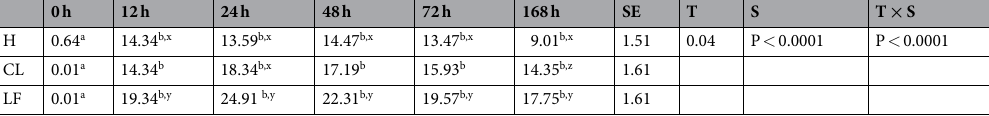
Table 1. Least square means (SEM) for serum IgG concentrations (mg/mL) from birth (d 0) to 168 h hours (h) for the calf progenies of H, CL and LF cows. T; Treatment, S (sampling time); H = Holstein; CL = Charolais × Limousin (n = 7), LF = Limousin × Friesian (n = 7); a,b Within rows, Lsmeans differ from d 0 by P < 0.05. x,y,z Within columns Lsmeans differ across breed by P <